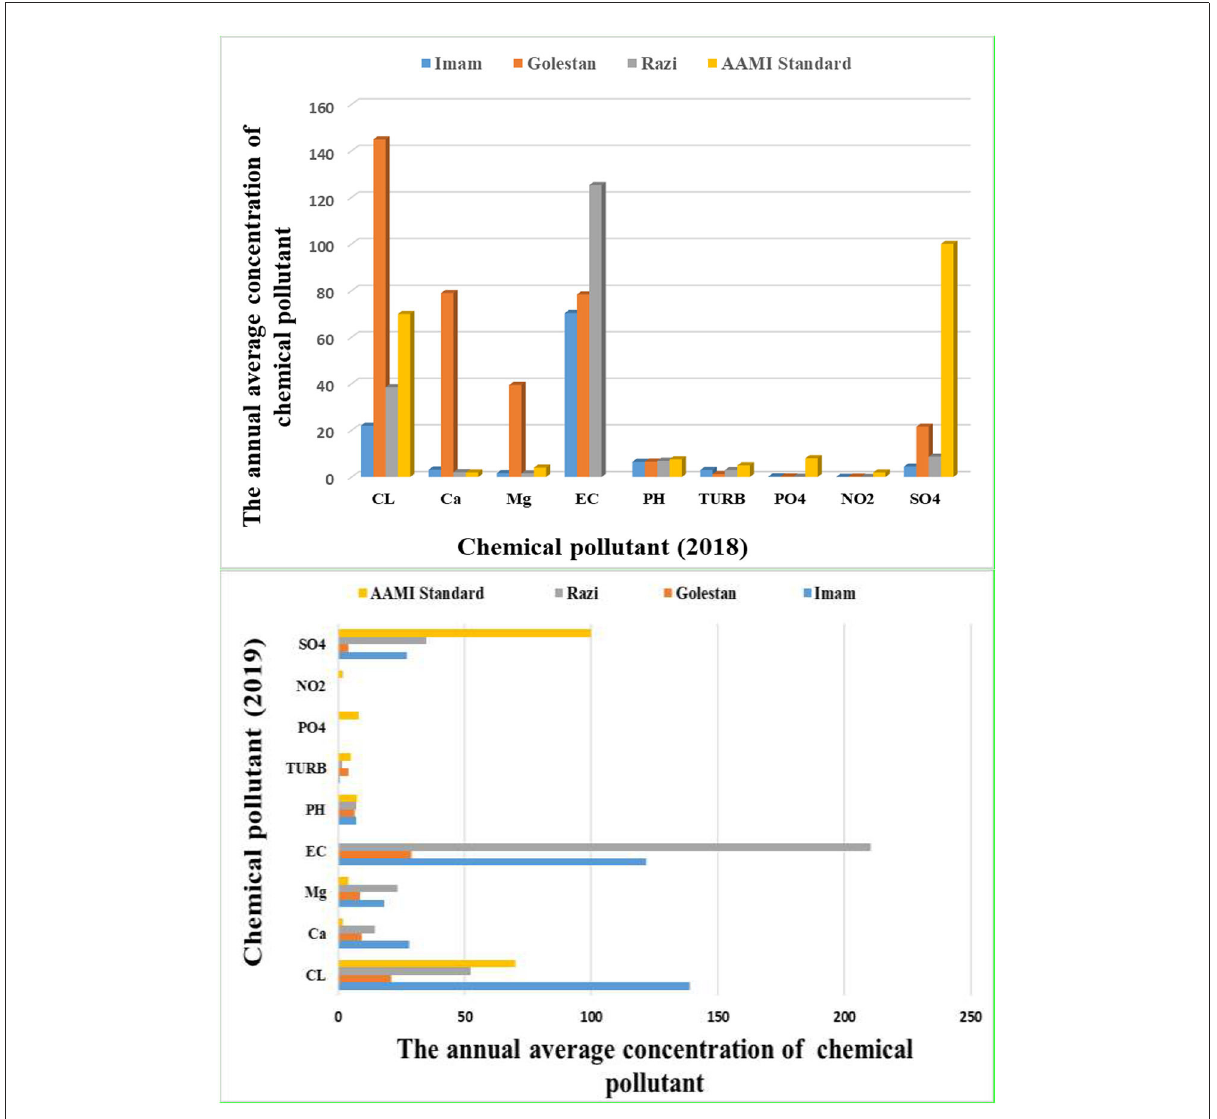
FIGURE3 The annual average concentration of chemical pollutant during 2018–2019.